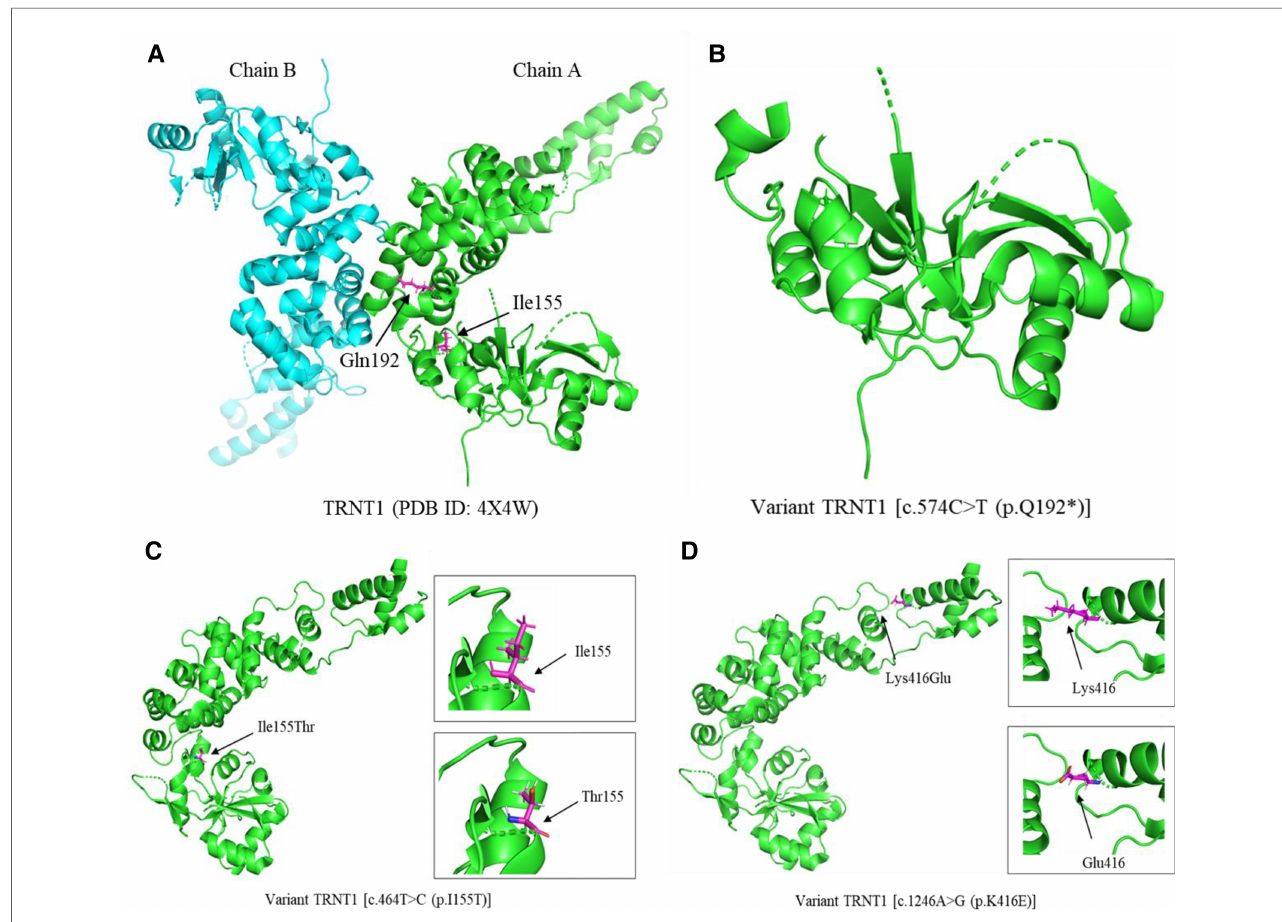
FIGURE 2 The cartoon diagram of 3D protein structure of TRNT1 and its variants. ( A) The resolved human protein structure of TRNT1 with its PDB identi fi cation (ID). ( B) The protein structure of variant TRNT1 [c.574C>T (p.Q192*)]. ( C) The protein structure of variant TRNT1 [c.464T>C (p.I155T)]. The black arrows point the amino acids isoleucine (Ile) and threonine (Thr) at the site of 155. ( D) The protein structure of variant TRNT1 [c.1246A>G (p.K416E)]. The black arrows point the amino acids lysine (Lys) and glutamate (Glu) at the site of 416. PDB, Protein Data Bank; ID, identi fi